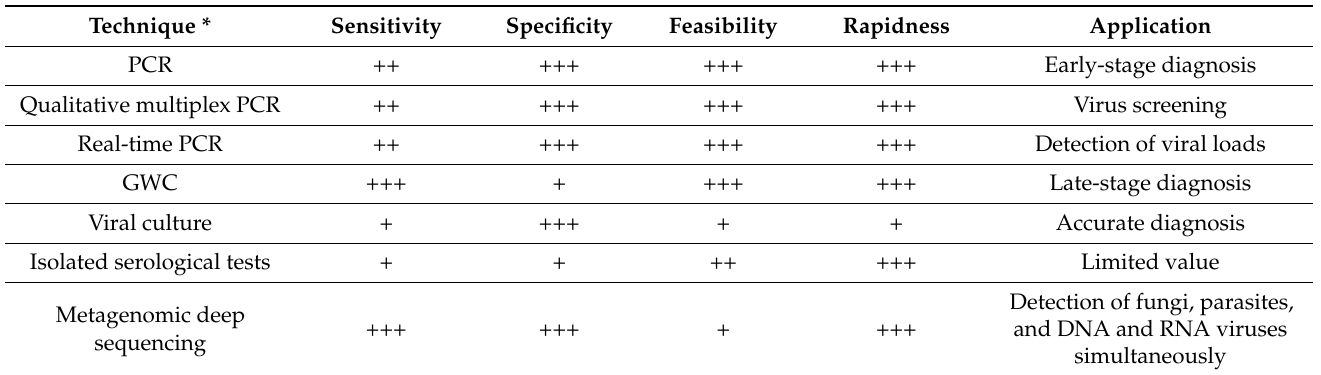
Table 2. Comparison of techniques for pathogenic